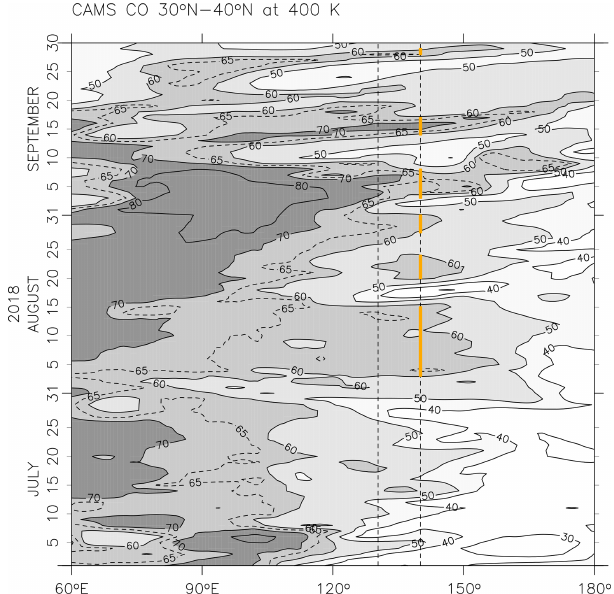
Figure 7. Longitude–time distribution of the daily averaged CO concentration at 400 K potential temperature averaged over 30– 40 ◦ N using CAMS reanalysis data. The contour interval is 10ppbv, with 65ppbv contours added (dotted). Vertical dotted lines indi- cate the locations of the two lidar sites in Fukuoka (130.36 ◦ E) and Tsukuba (140.1 ◦ E); furthermore, the periods along the longi- tude of Tsukuba when the CO concentration was ≥∼ 60ppbv (i.e.